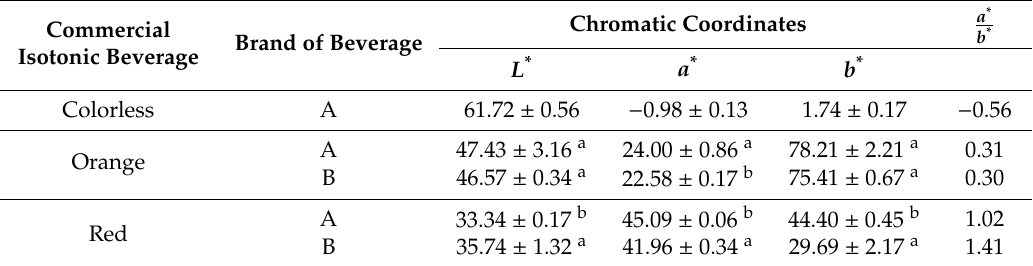
X ± S: mean value ± standard deviation. Different letters in the column values for each coloration of beverages indicate statically significant differences for p < 0.05.